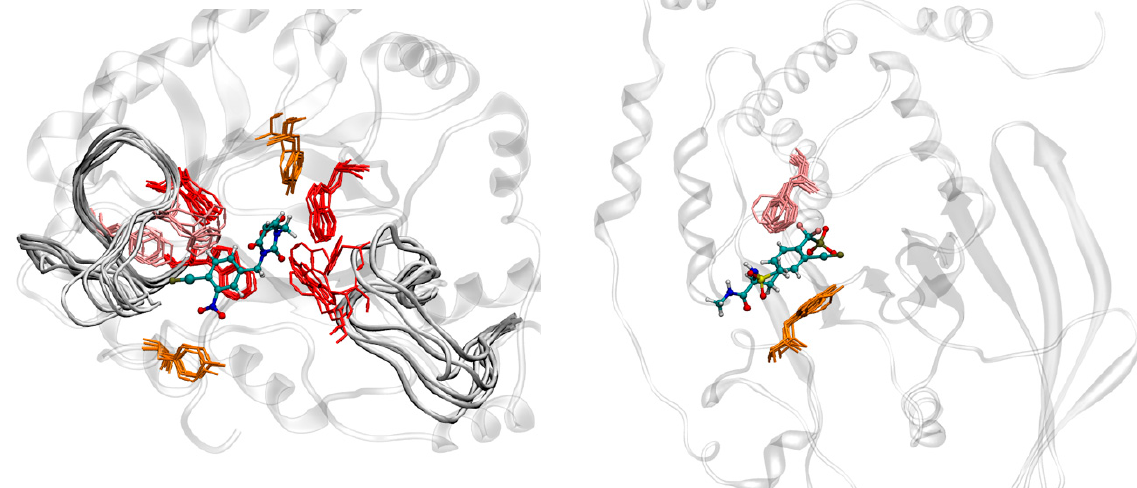
Figure 3. Snapshots of the Molecular Dynamics (MD) simulations of AR ( left ) and PTP-1B ( right ) with their respective cocrystallized ligands. The protein structure is shown in the white transparent illustration, ligands in CPK representation, and aromatic residues close to the binding pocket in licorice representation (red: tryptophan; orange: tyrosine; pink: phenylalanine). The superimposed snapshots illustrate the plasticity of the loops (and its aromatic residues) close to the binding pocket of AR.